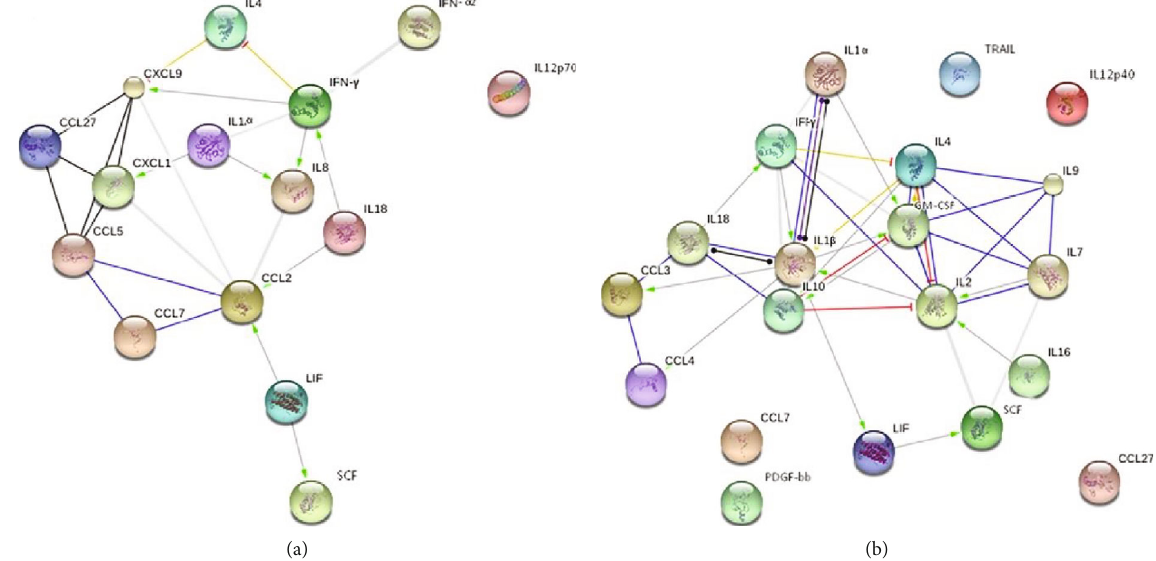
Figure 4: String analysis of cytokines signi fi cantly a ff ected in serum and CSF of MS. (a) serum MS; (b) CSF MS. Green — activation; blue — binding; black — reaction; thicker the line = stronger interaction; String 9.0 (http://string91.embl.de) high con fi dence 0.7. (a) set of cytokines uniquely a ff ected in serum of MS; (b) set of cytokines uniquely a ff ected in CSF of